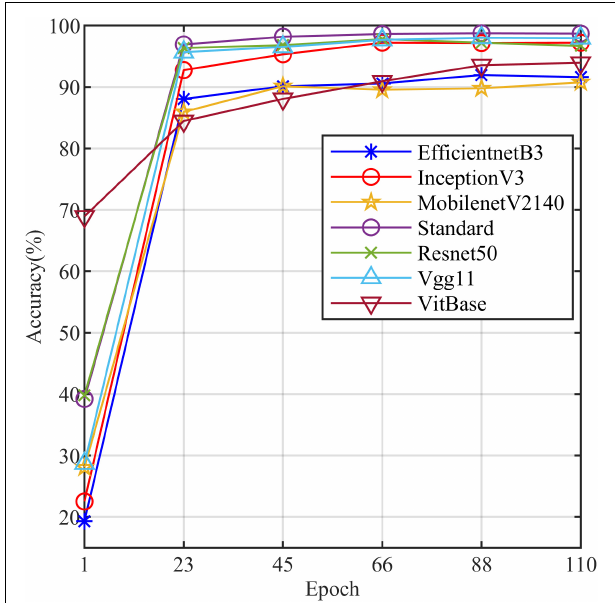
FIGURE 7 | The accuracy line chart of the standard model and the other models.